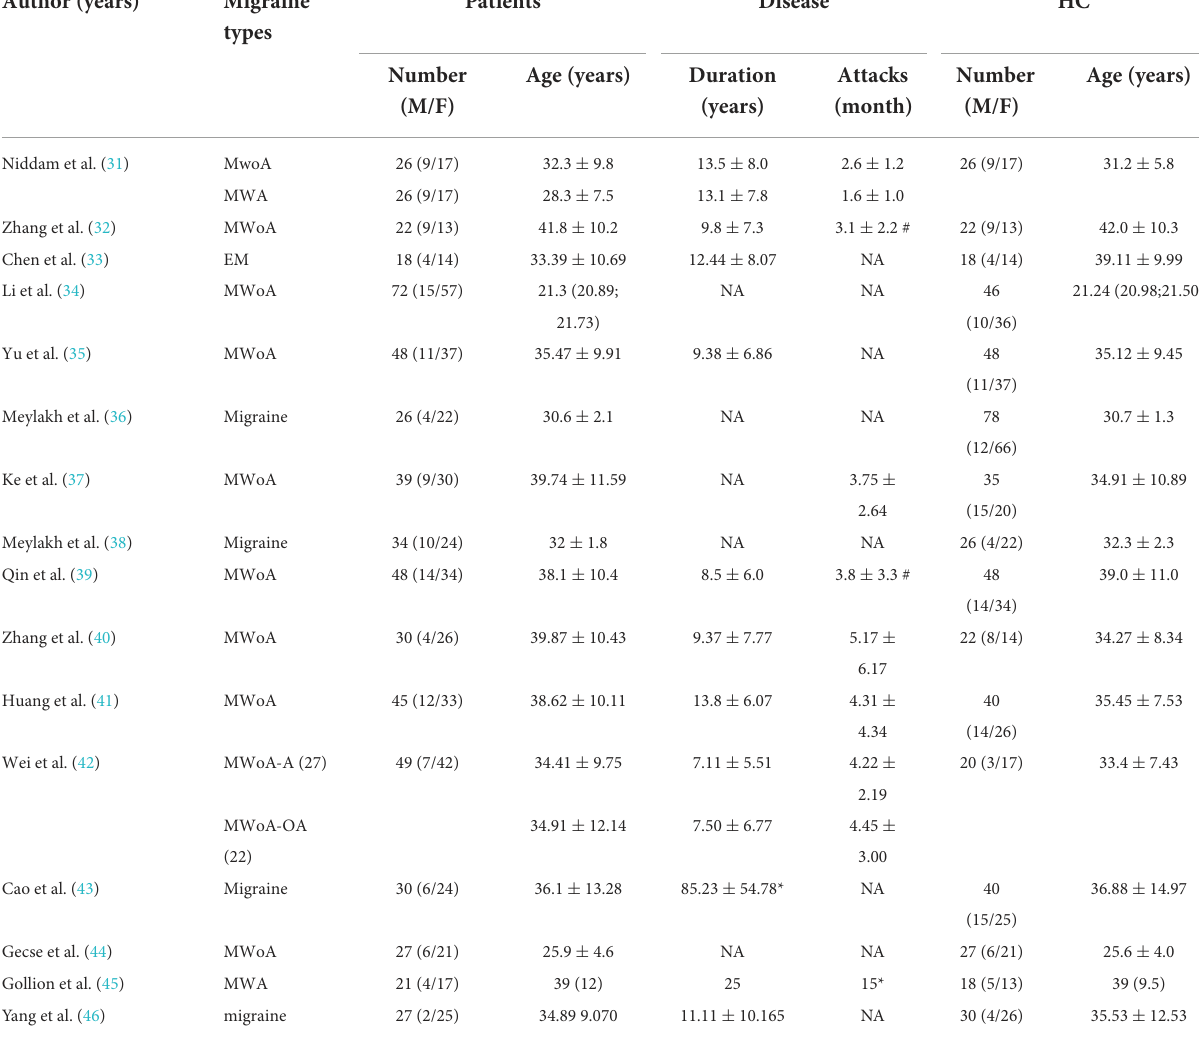
TABLE 2 Demographic and clinical characteristics of FC studies in